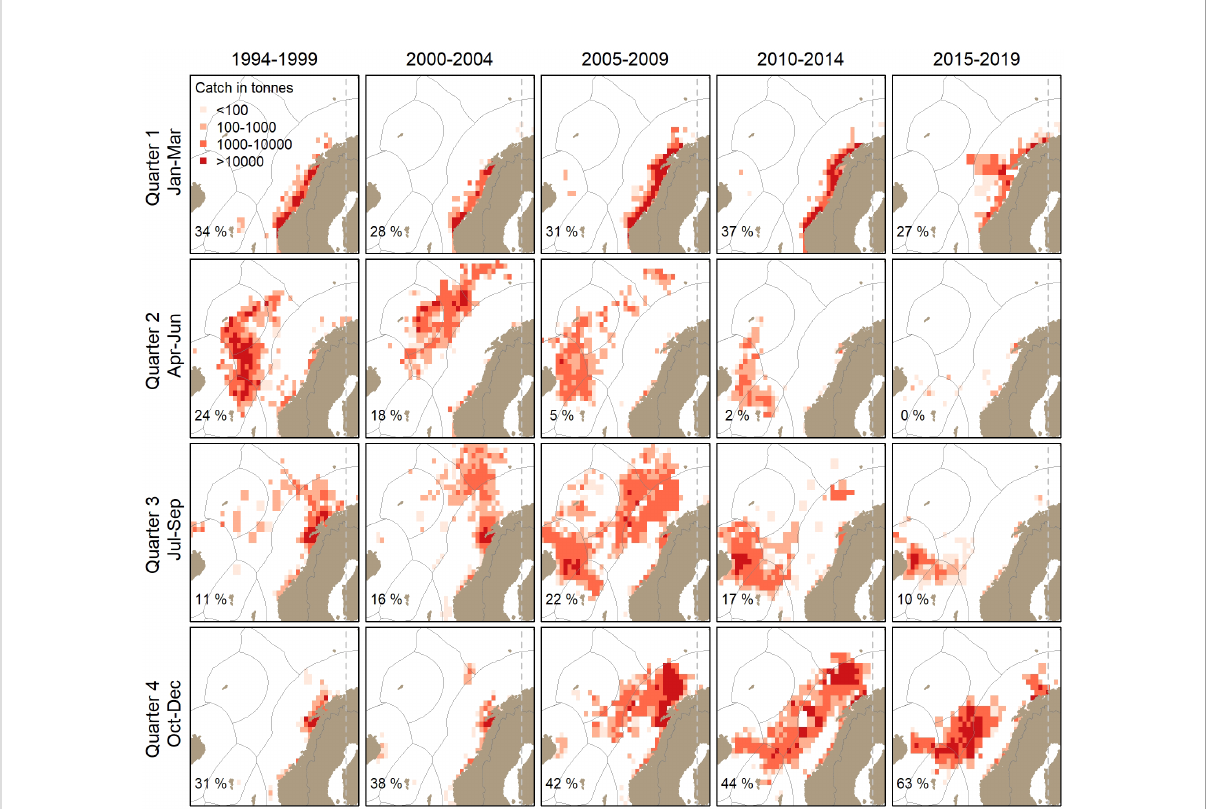
FIGURE 4 The Norwegian spring-spawning herring fi sheries of the Norwegian, Icelandic and Faroese fl eets by quarter of the year in fi ve-year intervals over the study period 1994-2019. Data are shown as sum of landings within a statistical rectangle (0.5° latitude, 1° longitude). Grey lines indicate national exclusive economic zones. In bottom left corner is given the percentage of the quarterly catch in relation to all year in the given